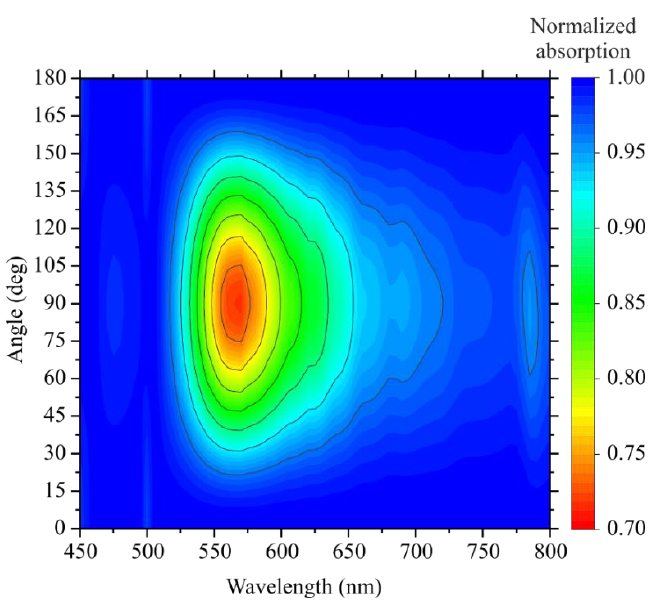
Figure 3. Calculated polarization-dependent absorption in the created photodetector (T = 500 nm) for different values of wavelength and azimuthal angle of the incident optical radiation polarization.